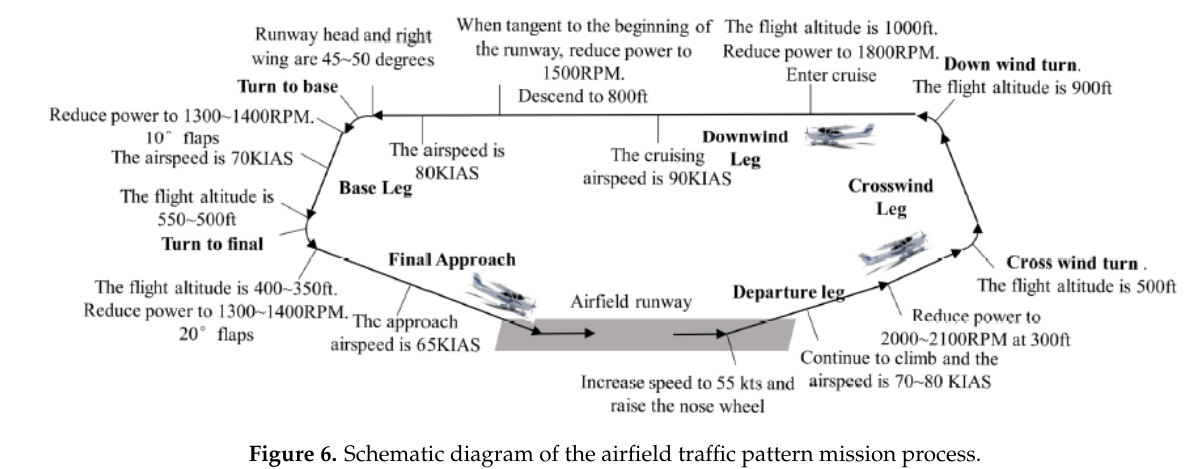
Figure 6. Schematic diagram of the airfield traffic pattern mission process.